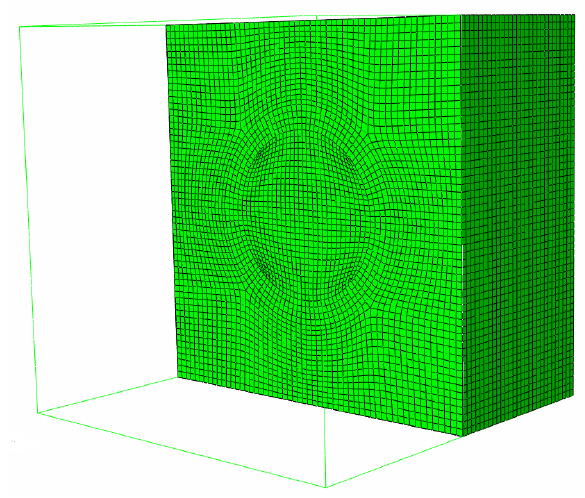
Figure 4. Mesh of the RVE.